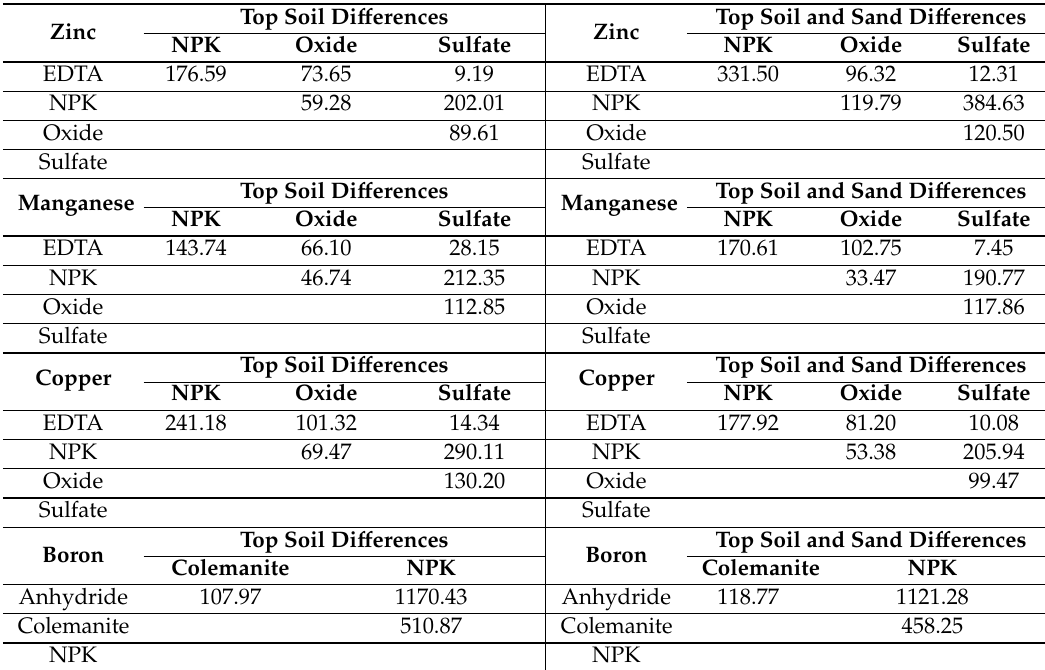
Table 3. Percentage di ff erences (%) of plant uptake of di ff erent sources of micronutrients tested in two the cations and anhydride for the anion) are more e ffi ciently taken up by plants in the short